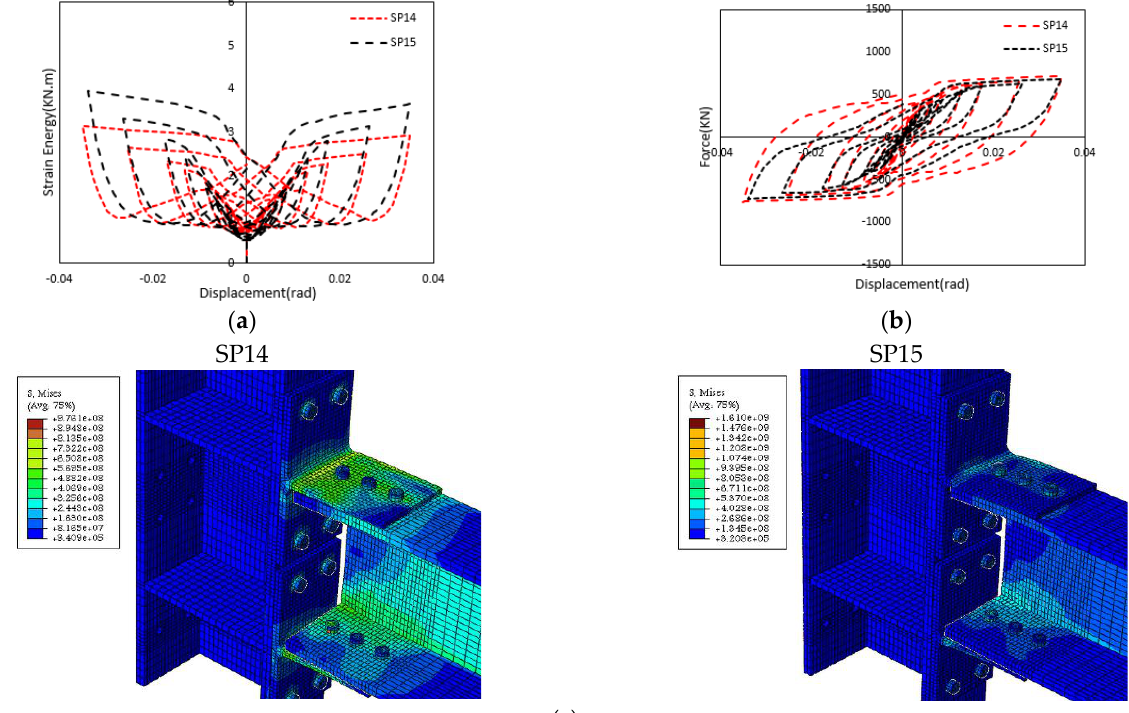
Figure 7. ( a ) Strain energy-displacement curve. ( b ). Force- displacement curve ( c ) Von Mises distribution.